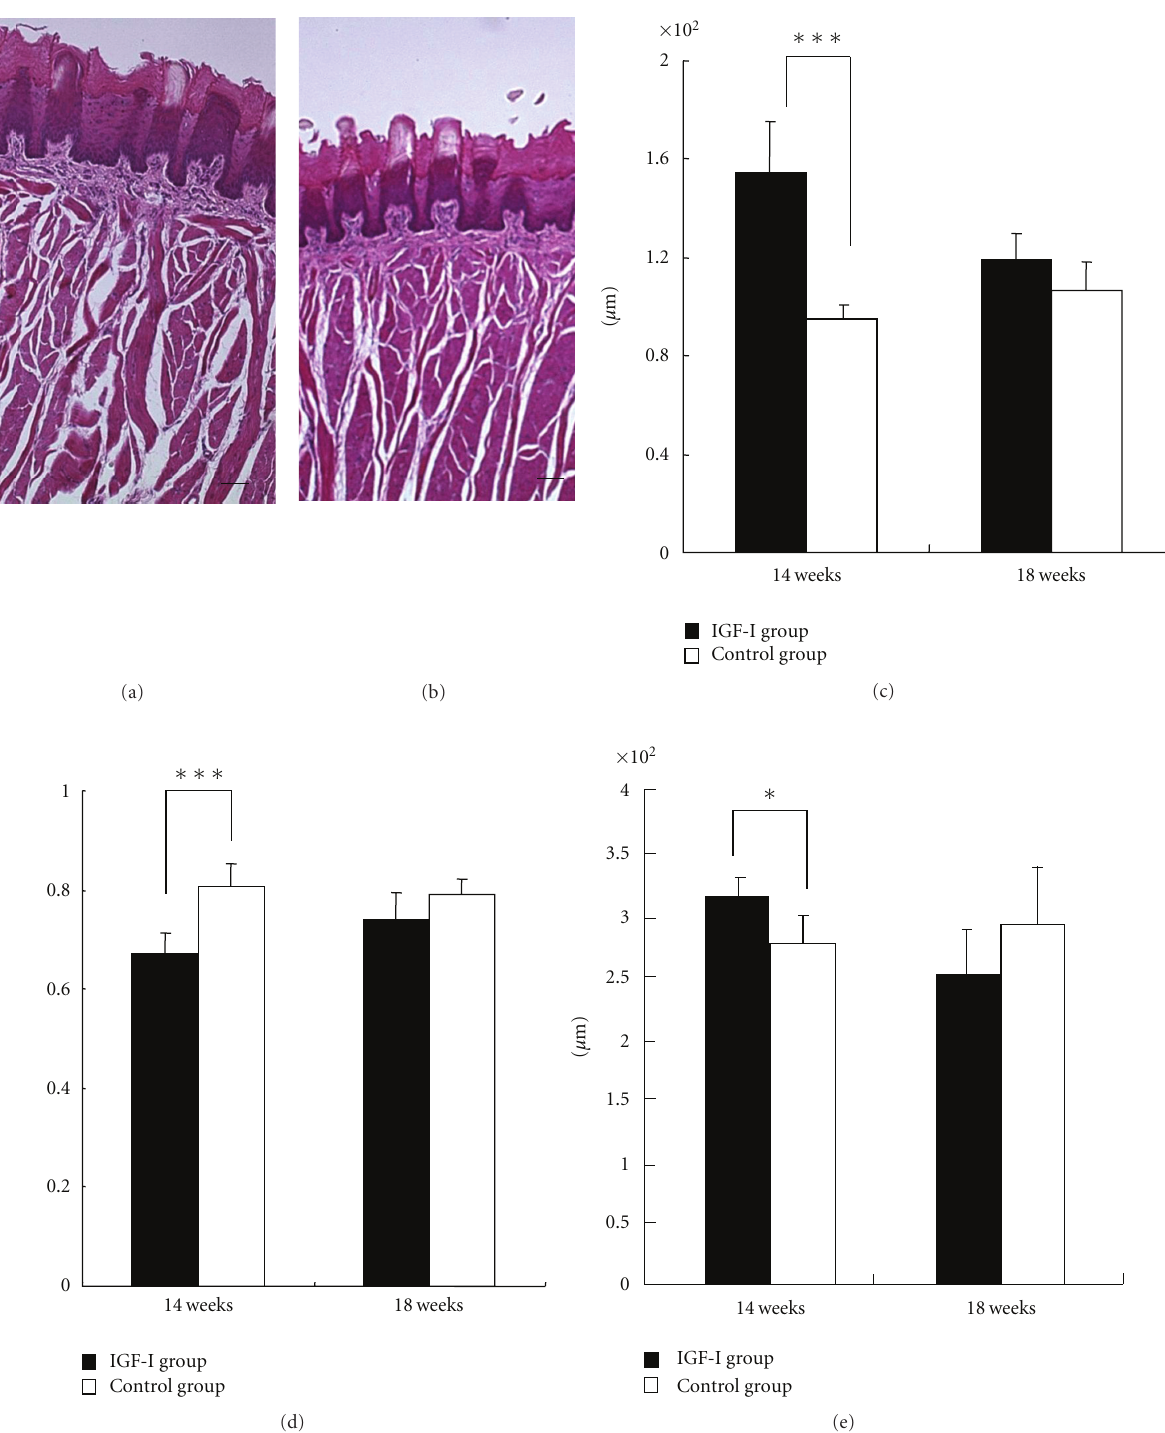
Figure 3: (a, b) Coronal sections of the dorsal superior longitudinal tongue muscle from an IGF-I-treated rat (a) and a control rat (b) at 14 weeks of age (hematoxylin-eosin staining, 100x magnification, bars = 100 μ m). (c–e) Muscle bundle width (c), ratio of the muscle parts (d), and total epithelial thickness (e). In (c–e), data represent the mean ± SD of six rats ( ∗ P < 0 . 05, ∗∗ P < 0 . 01, ∗∗∗ P < 0 . 001 versus control); adapted from a previous report